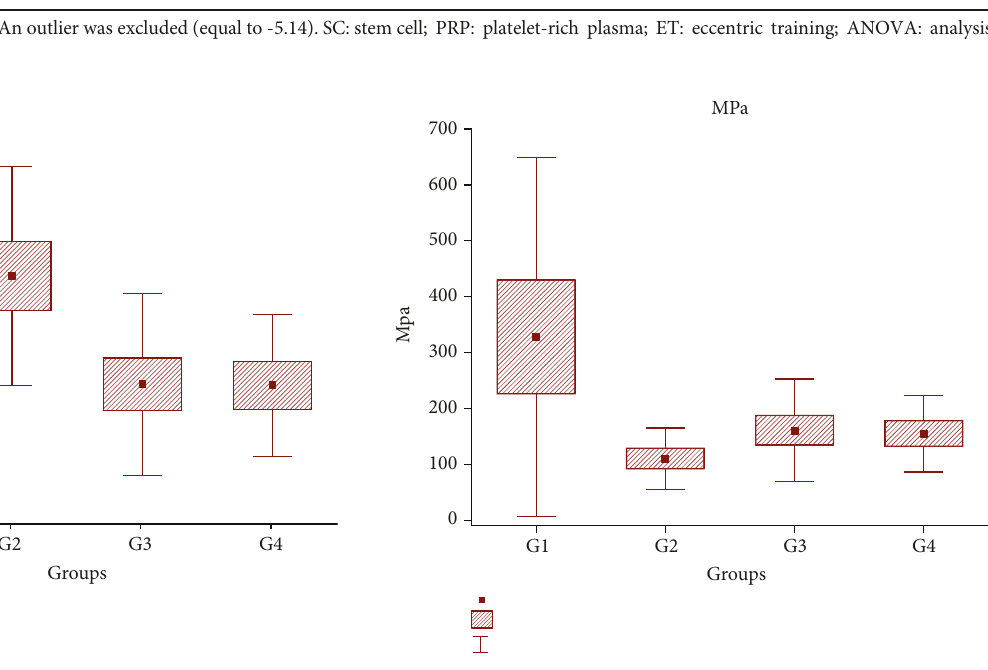
Figure 3: A histogram showing the elastic modulus, which is signi fi cantly lower in the PRP group and higher in the SC group. G1 = SC ; G2 = PRP ; G3 = SC +PRP; G4 = ET . MPa: elastic modulus; SC: stem cell; PRP: platelet-rich plasma; sd: standard deviation; se: standard